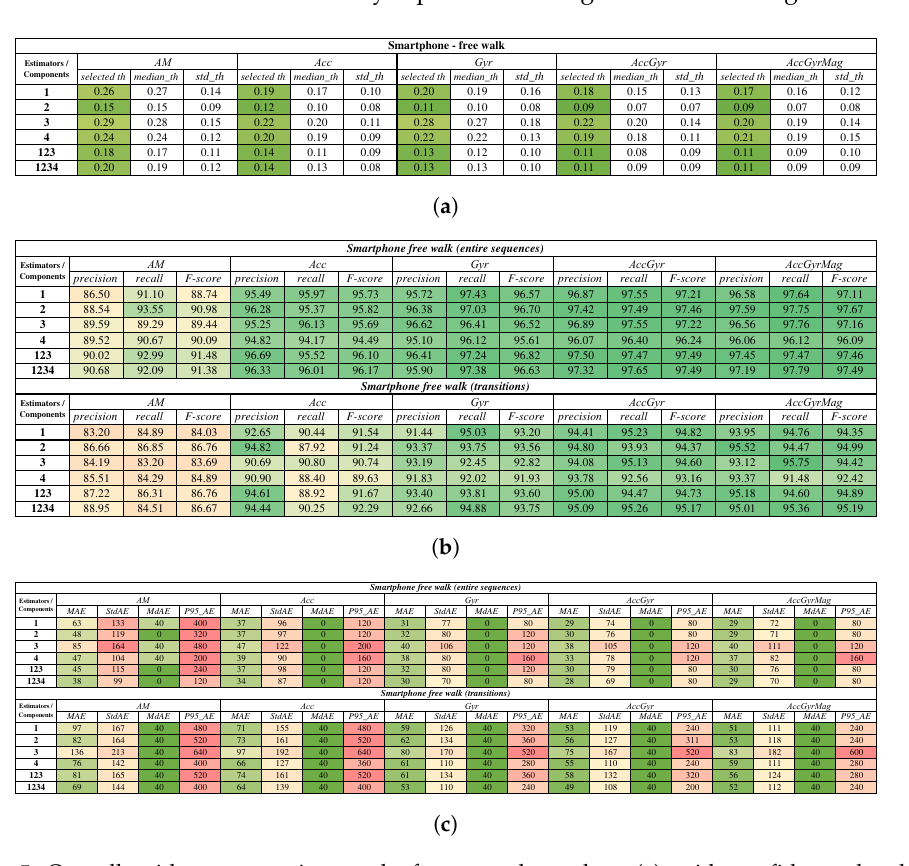
Figure 5. Overall stride segmentation results for smartphone data: ( a ) stride confidence threshold variability analysis based on v i ; ( b ) stride detection efficiency; ( c ) stride detection accuracy. The values are also represented by a green-yellow-red color scale for a better